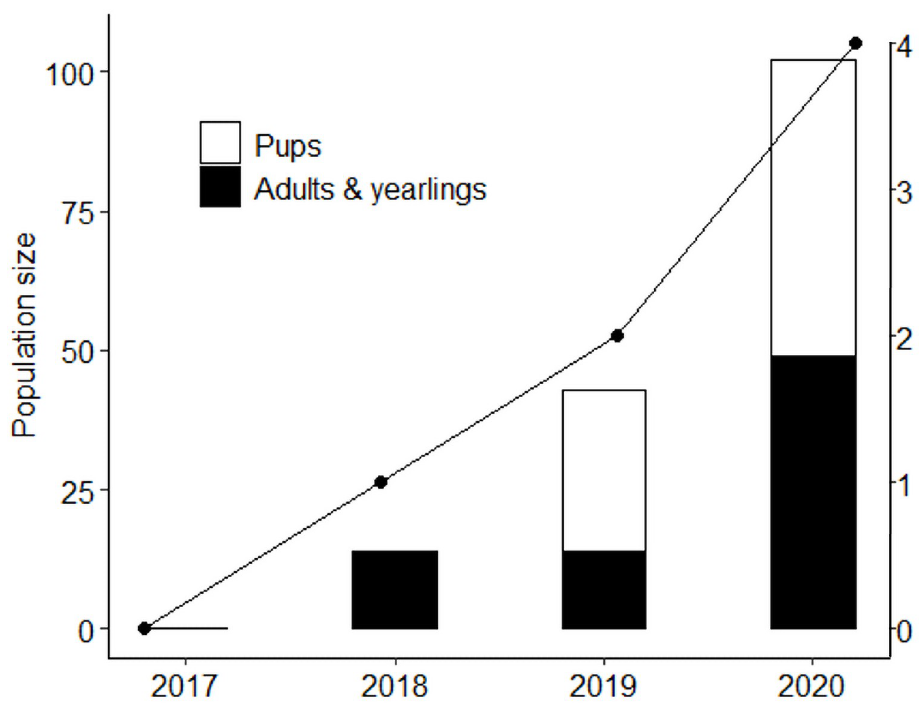
Fig 3. Annual time series of the wild dog population in Gorongosa National Park from one year prior to their reintroduction (in 2017) until 2020. Counts were taken in June of each year representing the midpoint in the annual breeding season. Bars represent the total number of individuals in the population (primary y-axis) with the solid line representing the number of packs (secondary y-axis).